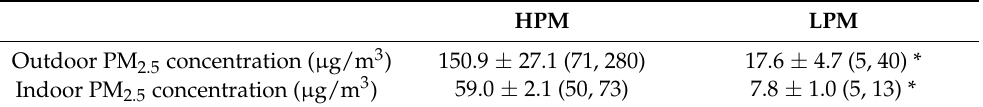
Table 2. Outdoor and indoor PM 2.5 concentrations during exercise intervention.